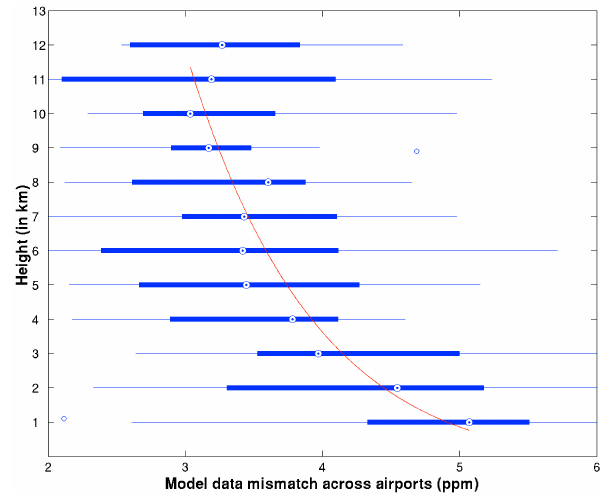
Figure 1. Box plot showing the model data mismatch between the TM3-analysed CO 2 fields and the vertical profiles from the CON- TRAIL project plotted against height. The red line shows the expo- nential curve fitted to the median of the standard deviation of the model data